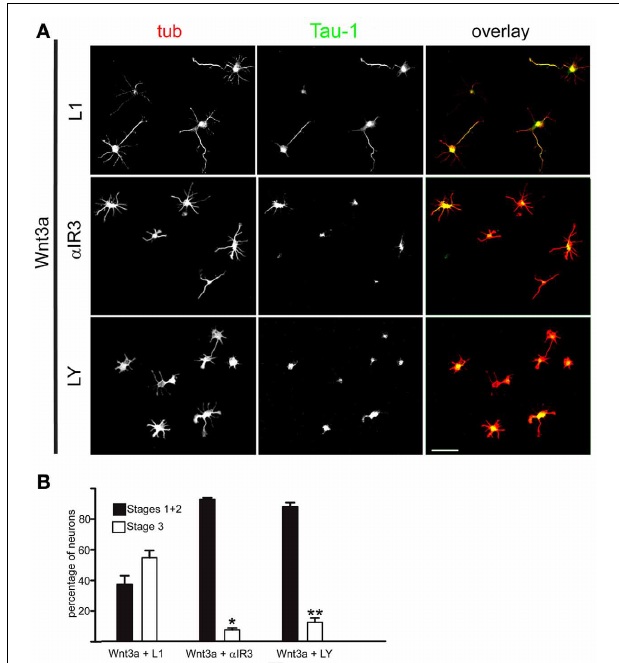
FIGURE 3 | An IGF-1r blocking antibody or the PI3k inhibitor LY294002 hindered the polarizing effects of Wnt3a. (A) Double immunofluorescence micrographs of hippocampal neurons after 20h in culture showing the distribution of the neuronal marker β -III tubulin (tub) and the axonal marker Tau-1, Cells were cultured in medium containing 1.35nM Wnt3a plus an antibody to L1 (top), 1.35nM Wnt3a plus the IGF-1r blocking antibody α IR3 (middle), or 1.35nM Wnt3a plus the PI3k inhibitor LY294002 (bottom). (B) Percentage ( ± sem) of neurons at different stages of differentiation grown for 20h in medium containing 1.35nM Wnt3a plus the anti-L1 antibody, 1.35nM Wnt3a plus the IGF-1r blocking antibody α IR3, or 1.35nM Wnt3a plus the PI3k inhibitor LY294002 ( n = 3 independent experiments). At least 100 cells were scored for each condition. ∗ p < 0 . 001 compared with Wnt3a + L1; ∗∗ p < 0 . 001 compared with Wnt3a ( Figure 1B , right). Scale bar: 100 μ m.